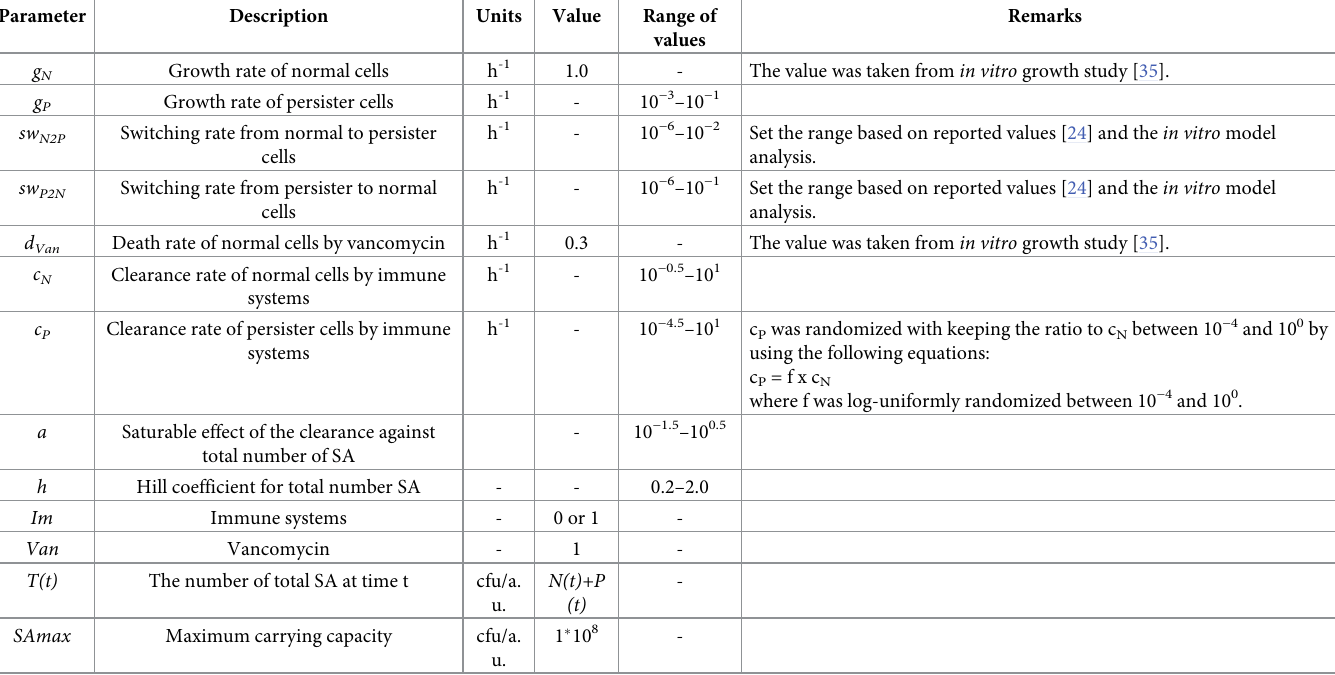
Table 2. Definition and values of the parameters for in vivo SA growth